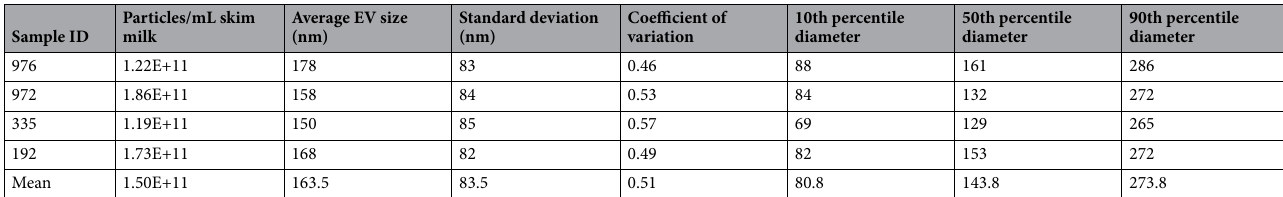
Table 2. Characteristics of human milk EVs in four representative